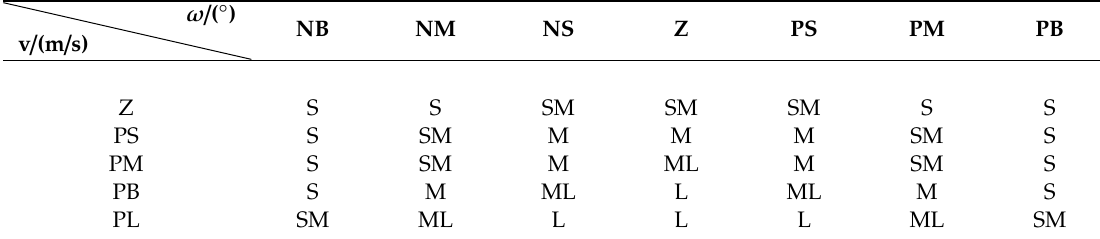
Table 1. Foresight distance fuzzy control lookup table.